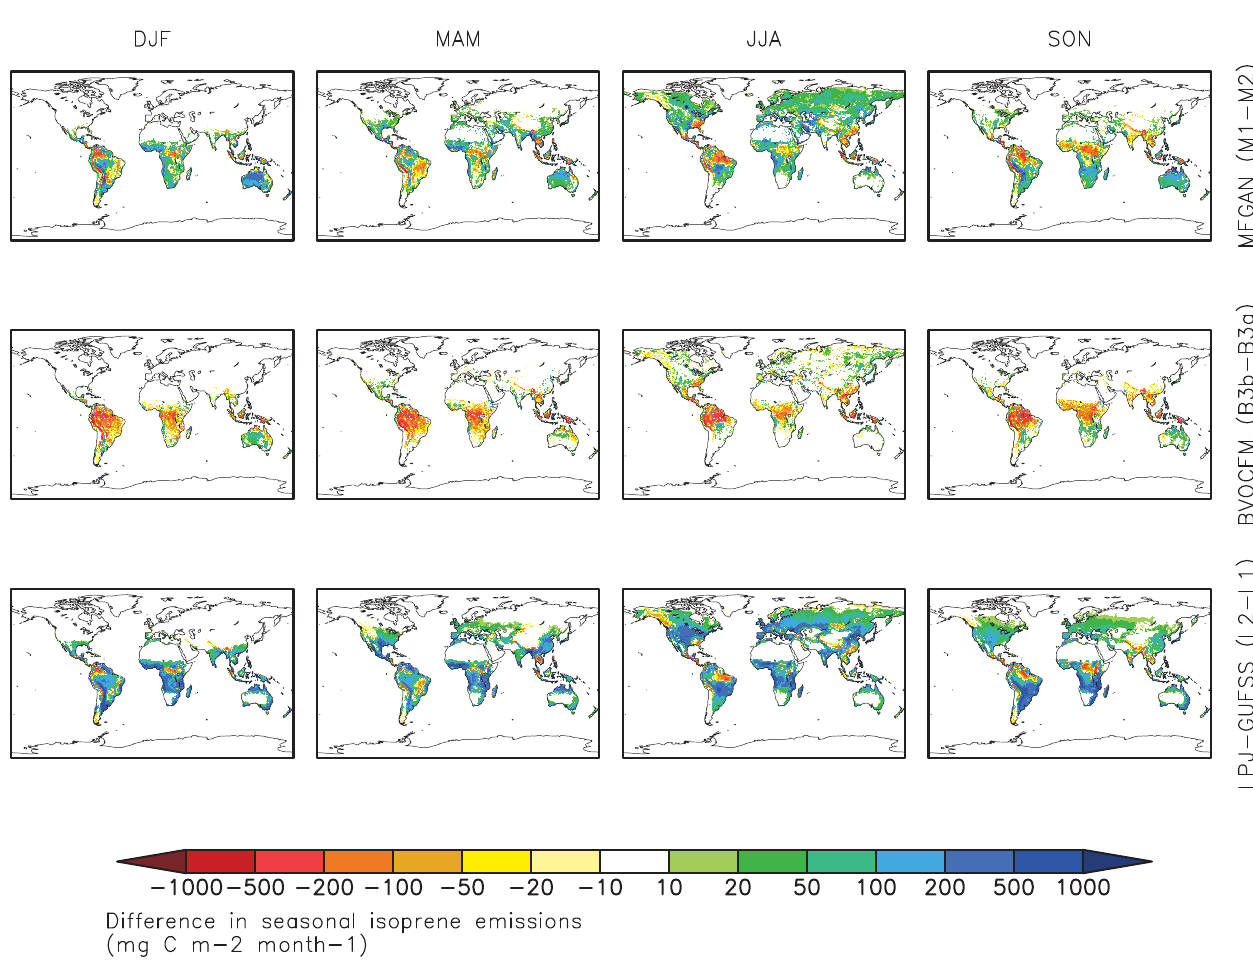
Fig. 3. Difference in isoprene emissions (mgCm − 2 month − 1 ) for simulations performed with NCEP climate minus simulations with CRU climate (top: M1–M2; middle: B3b-B3a; bottom: L2–L1; see Table 1). In the case of the dynamic vegetation models, the differences shown are those with fixed vegetation (L2: LPJV f ); and in case of BVOCEM, MEGAN vegetation was applied. Panels show monthly averages over three-month periods December to February (DJF); March to May (MAM); June to August (JJA); September to November